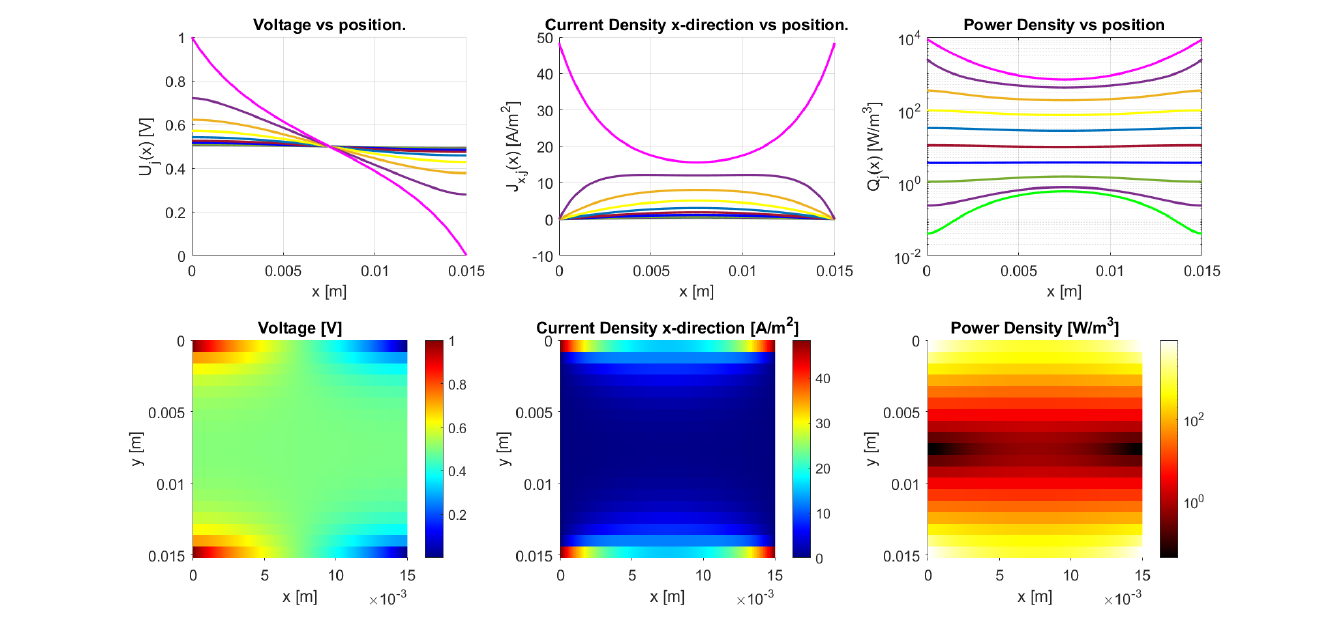
Figure 28. Connecting multiple inputs and outputs is possible, like connecting all corners. In this specific example, open- ended traxels are used with an inter-traxel resistance of σ = 2 × 10 − 2 Ω m 2 combined with the other parameters from Table 2, providing an anisotropy ratio of